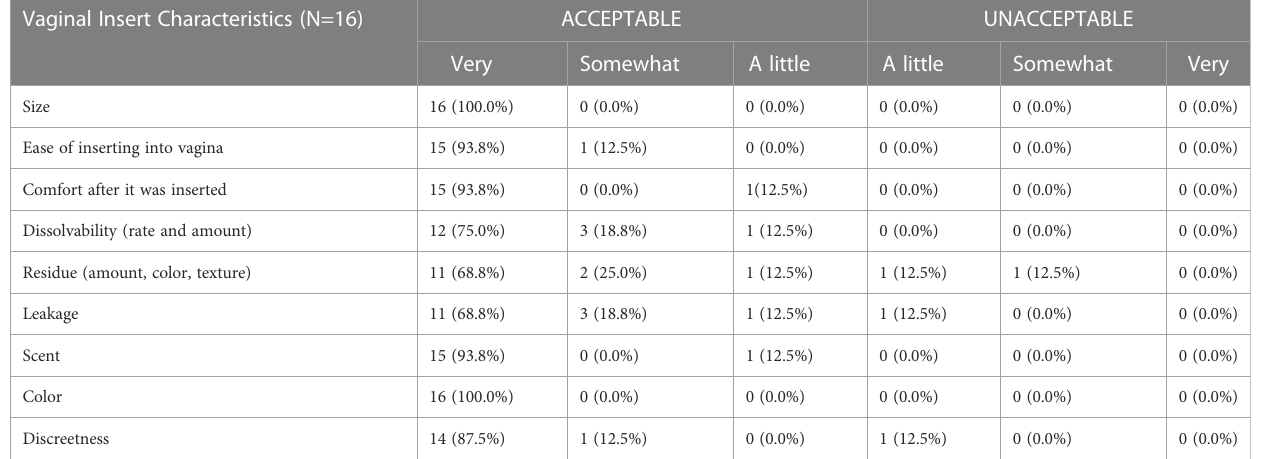
TABLE 6 Acceptability of insert